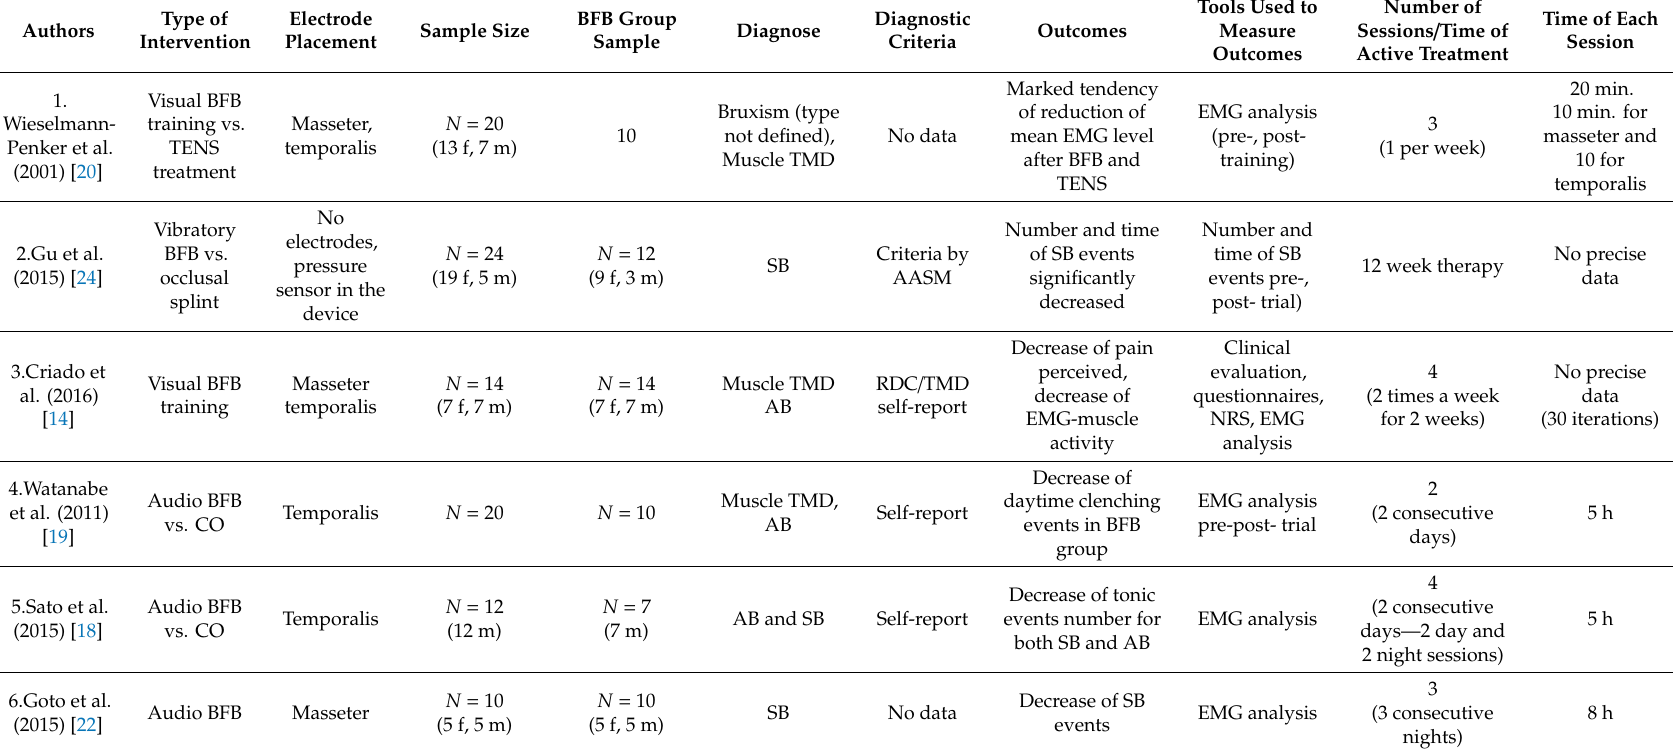
Table 1. Summary of included studies using biofeedback